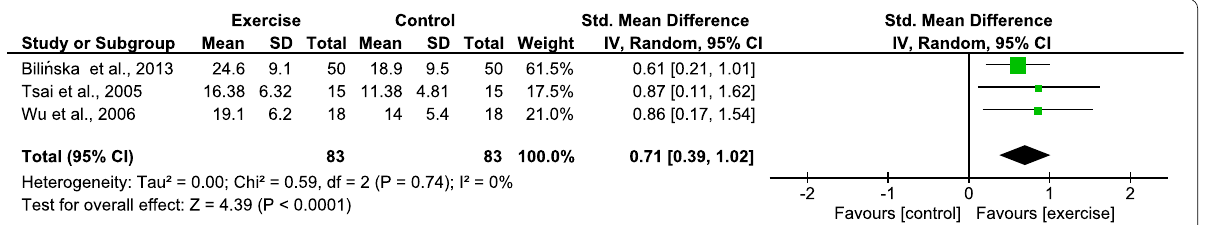
Fig. 4 Forest plot for HRR 1 : overall changes in standardized mean difference indices for heart rate recovery in the first minute after exercise (HRR 1